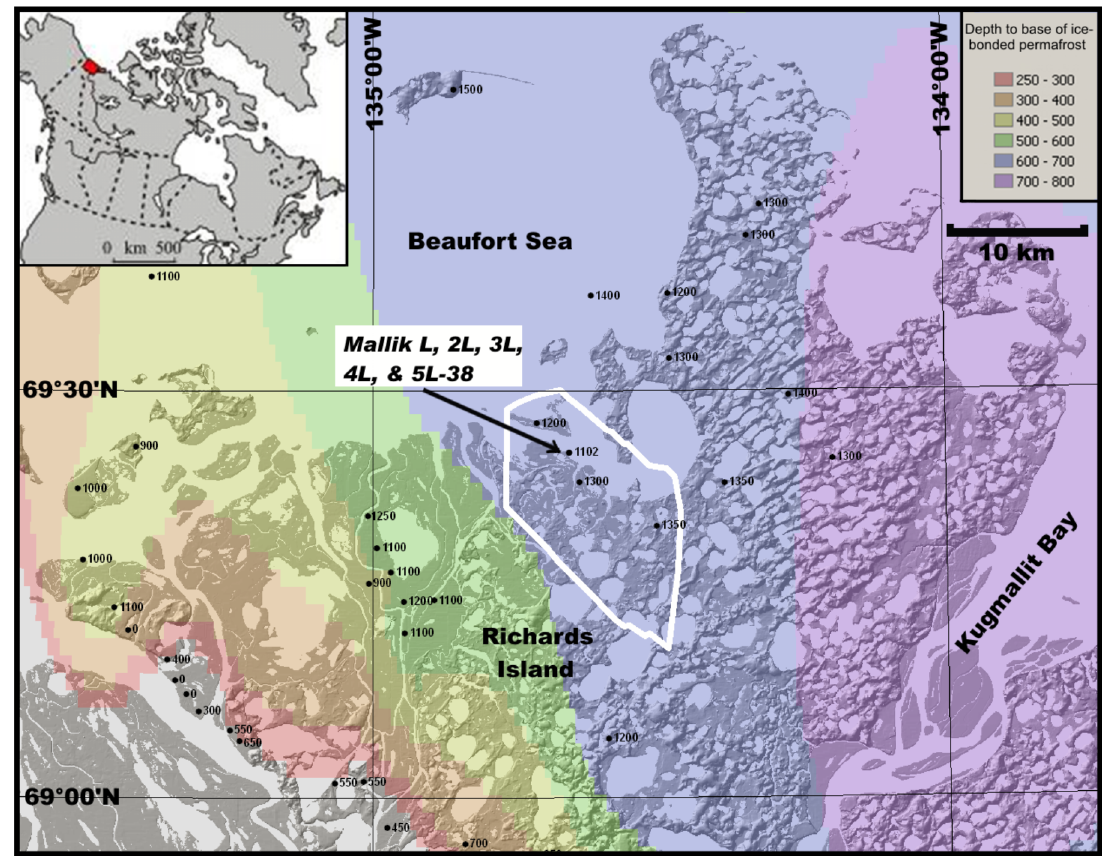
Figure 1. Study area and Mallik GH field location (according to [2]). Numbers posted by black dots (wells) are depths (m) to base GH stability